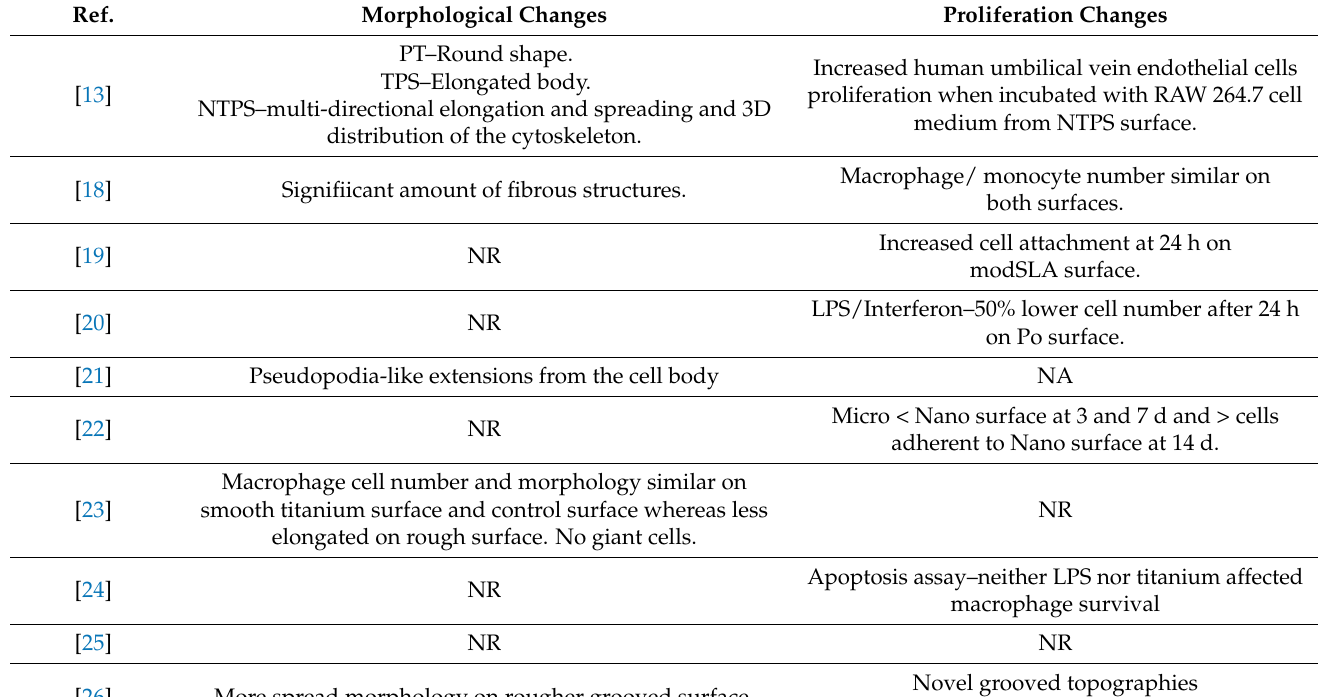
Table 4. Summary data (Morphological and Proliferative Changes) of studies included in review. (NA) not applicable in this study, (NR) not recorded in this